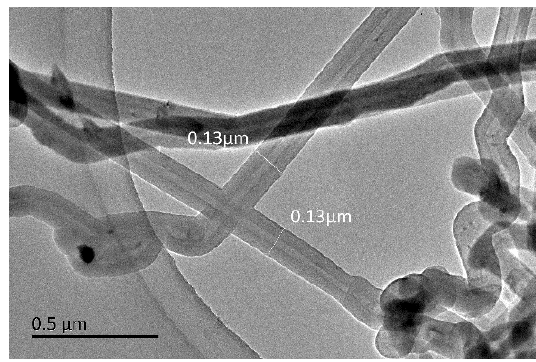
Figure 1. The SEM micrograph of the carbon fiber.